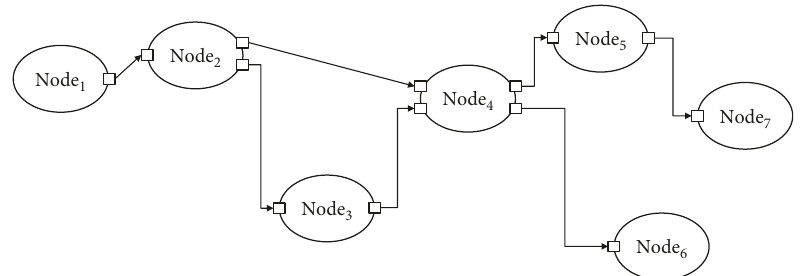
Figure 5: Sequential property for interpreting fi